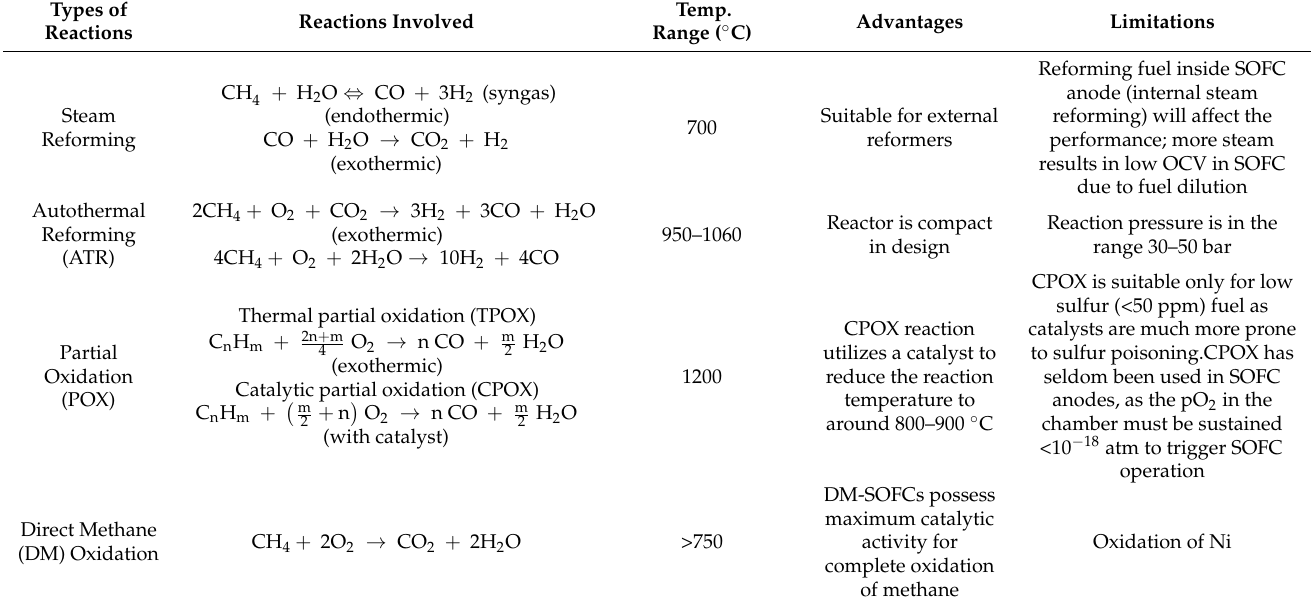
Table 1. Different reactions of HCs occurring at the operating conditions of SOFC along with their advantages and limitations. Types of